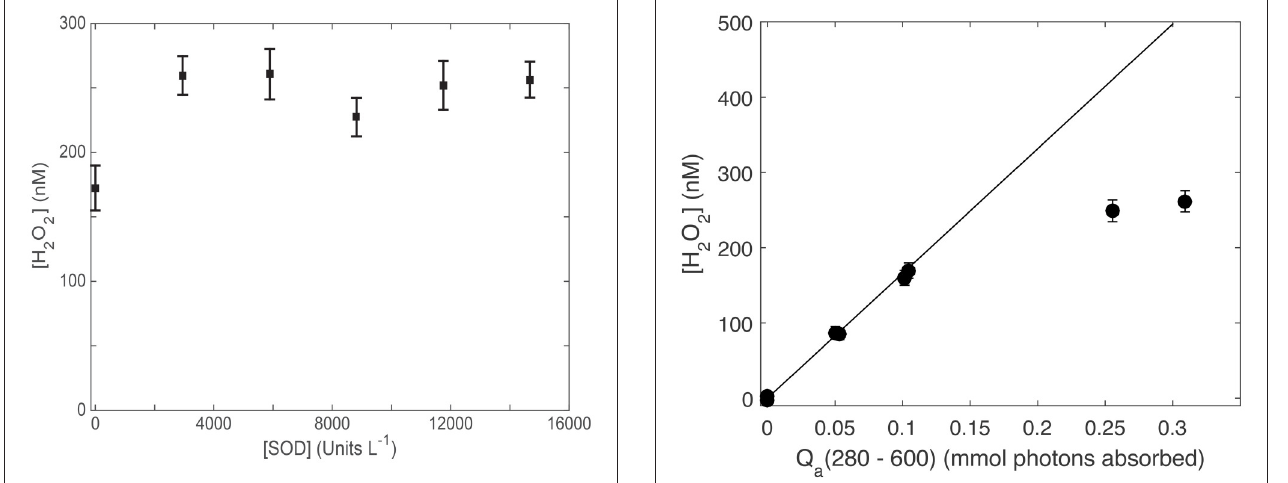
FIGURE 2 | Photoproduced H 2 O 2 (nM) vs. absorbed photon dose integrated from 280 to 600 nm (Q a , mmol photons absorbed). The solid line represents the linear production rate over the first hour of irradiation (absorbed photon dose of ∼ 0.05 mmol photons) using only H 2 O 2 at the first time point.